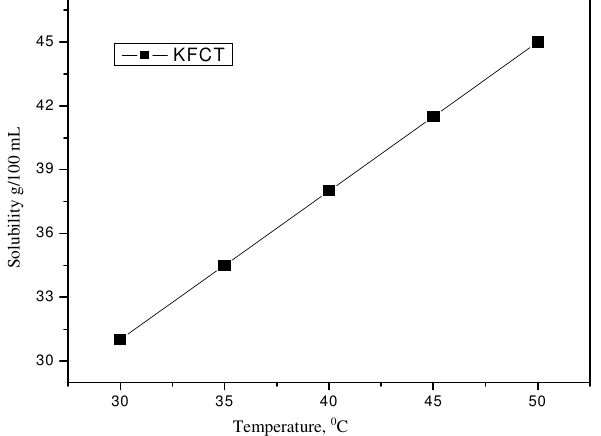
Figure 1. Solubility of KFCT as a function of temperature in aqueous